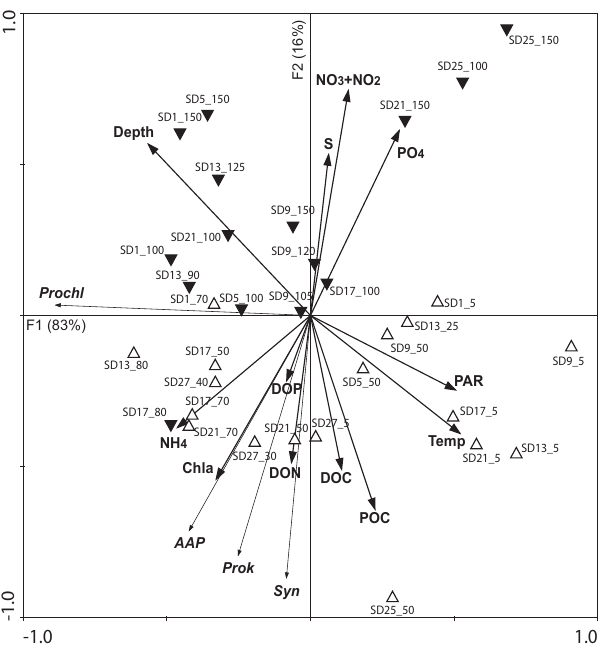
Fig. 5. Redundancy analysis using the abundances of AAP bacte- ria (AAP), total prokaryotes (Prok), Prochlorococcus (Prochl) and Synechococcus (Syn) as dependent variables (thin arrows) and tem- perature (Temp), salinity (S), depth, photosynthetically active radi- ation (PAR), concentrations of Chl- a (Chl- a) , nitrite + nitrate (NO 2 + NO 3 ) , phosphate (PO 4 ) , ammonium (NH 4 ) , dissolved organic carbon (DOC), nitrogen (DON) and phosphorous (DOP) and par- ticulate organic carbon (POC) as explanatory variables (thick ar- rows). The samples are identified as “below the euphotic zone” (black down-triangles) or “euphotic zone” (open up-triangles) sam- ples. In the name of the samples, the first number corresponds to the number of the sampling station and the second number to the sampling